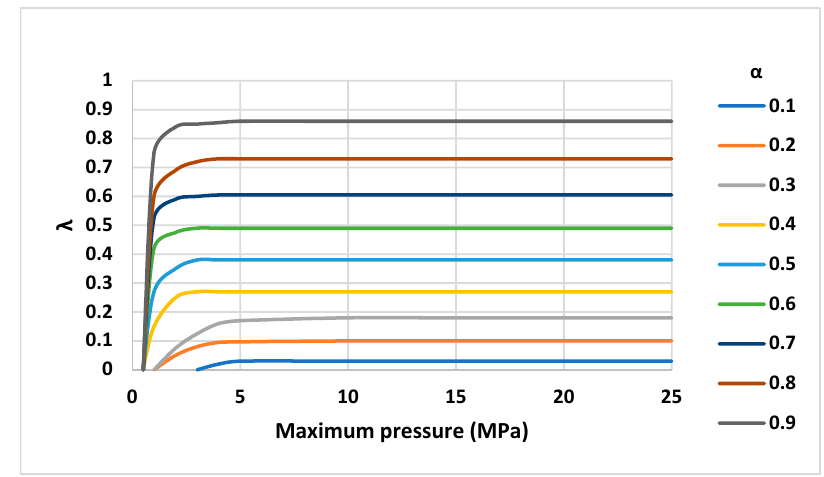
Figure 9. The difference λ between the maximum and minimum operating pressures is considered relative to α .